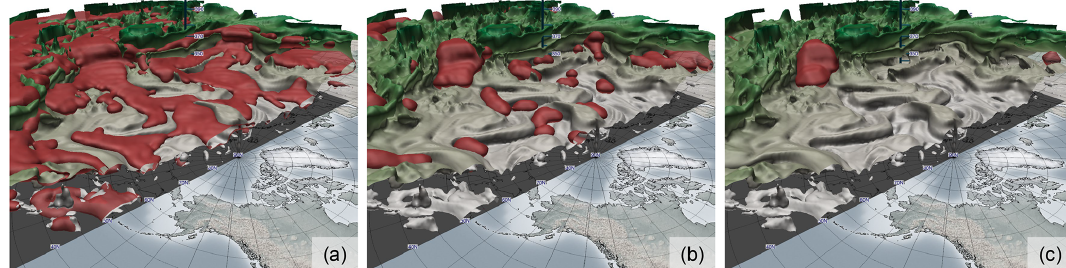
Figure 11. Effect of filtering anomaly candidates with respect to the extent threshold b . Areas of anomalies with a vertical extent smaller than b are omitted from the identification; this leads to clear and separated features. (a) b = 0K (no filtering); (b) b = 6K; (c) b = 12K. As specified in Sect. 6, our default configuration is